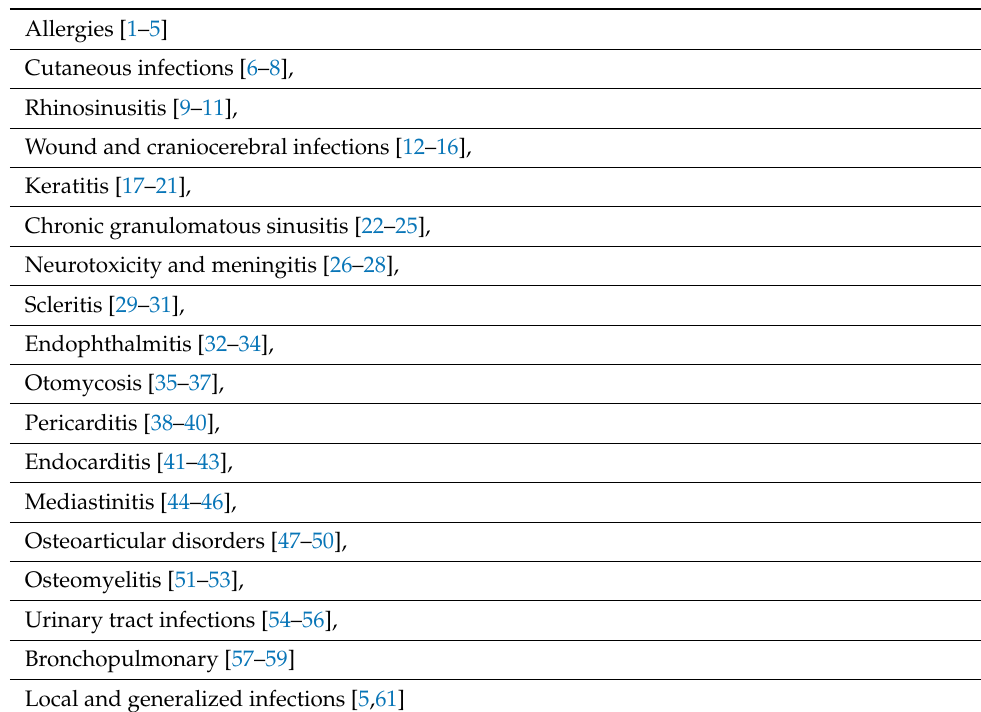
Table 1. Major non-mycotoxin-related pathogenic effects of Aspergillus